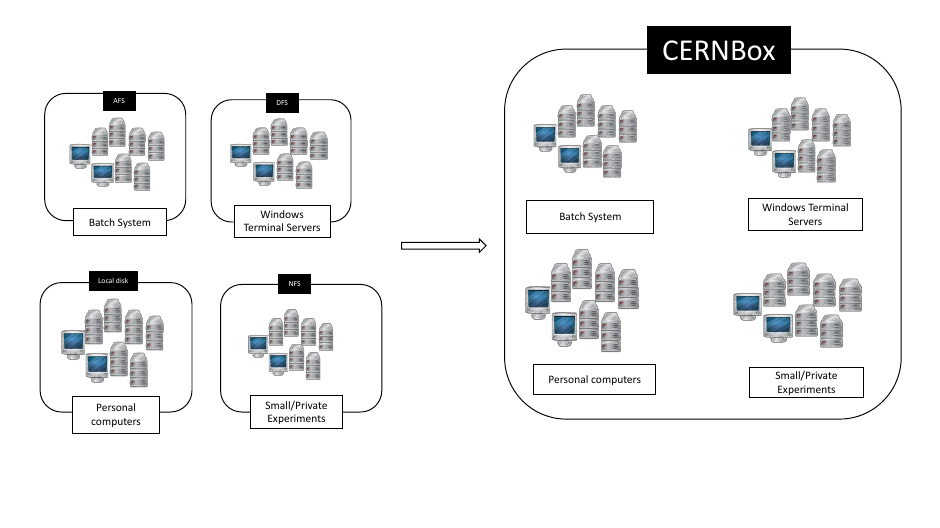
Figure 10. Consolidated view for a home directory service using